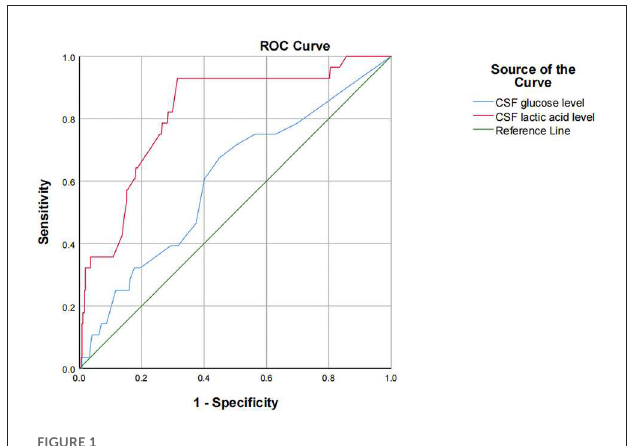
FIGURE1 Roc curve of cerebrospinal fluid glucose and lactate